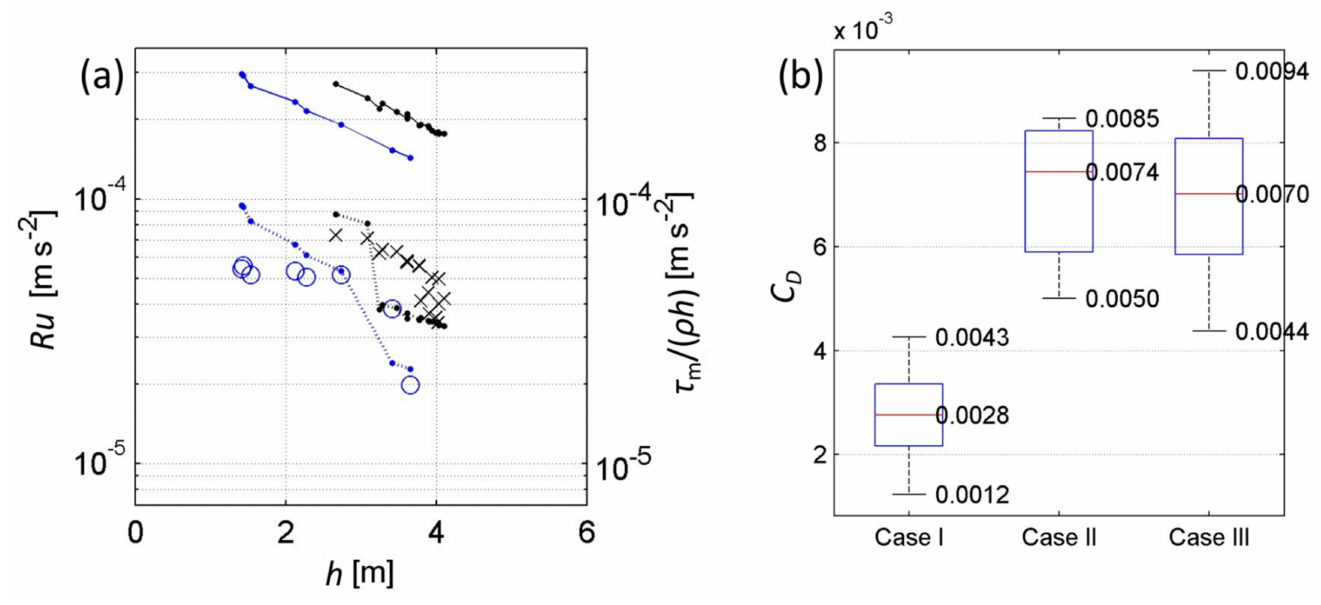
Figure 12. ( a ) Bottom drag term, Ru , and bottom stresses induced by waves and currents, τ m / ρ h , versus water depth, h . Black refers to Case II, and blue refers to Case III. Circles and cross markers without lines refer to Ru from drifter observations. Dots with dashed lines refer to the results using the Soulsby (1997) method. Dots with solid lines refer to the results using the Grant–Madsen (1979) method. ( b ) Boxplots of the bottom drag coefficient ( C D ) of Case I, II, and III, where C D = Rh / u